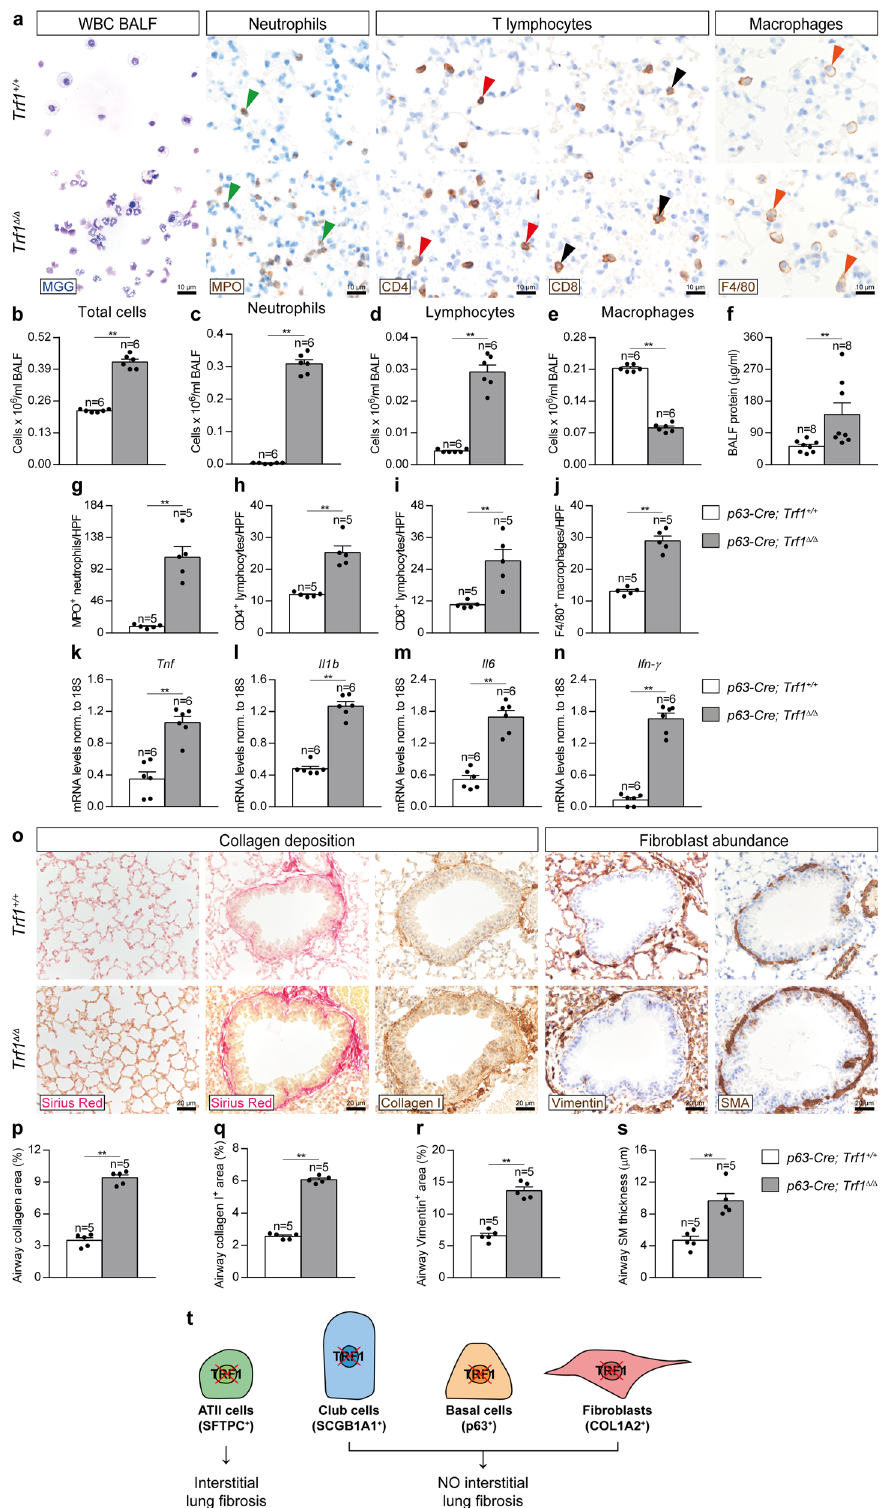
Agilent technologies, Santa Clara, CA). Telomere Q-FISH analyses After deparaf fi nization and rehydration, tissues underwent antigen retrieval in 10mM sodium citrate buffer and permeabilization was performed in PBS 0.5% Triton X-100 for 3 h. Next, tissues were